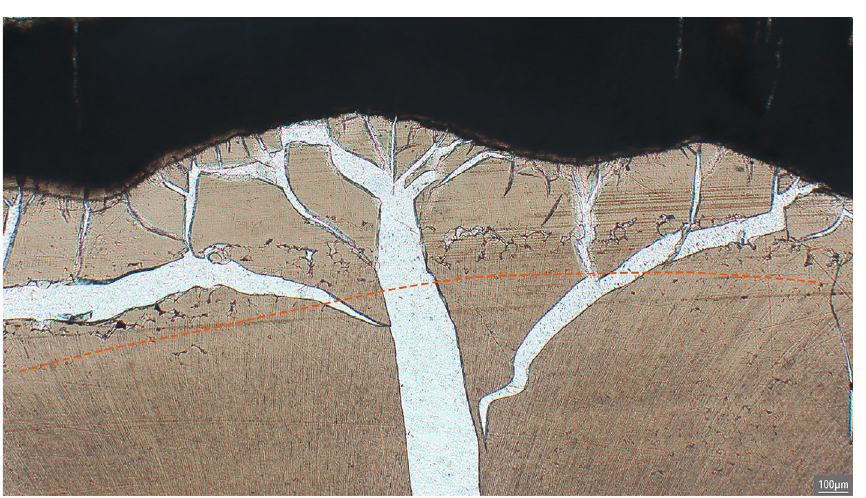
Figure 4. IGD in B61 (Grade 2) burned at 900 °C for 2 h, visible as a band of not fully fused calcospherites just above the dashed orange line. Note the heat-induced damage (white cracks) to the dentine (light